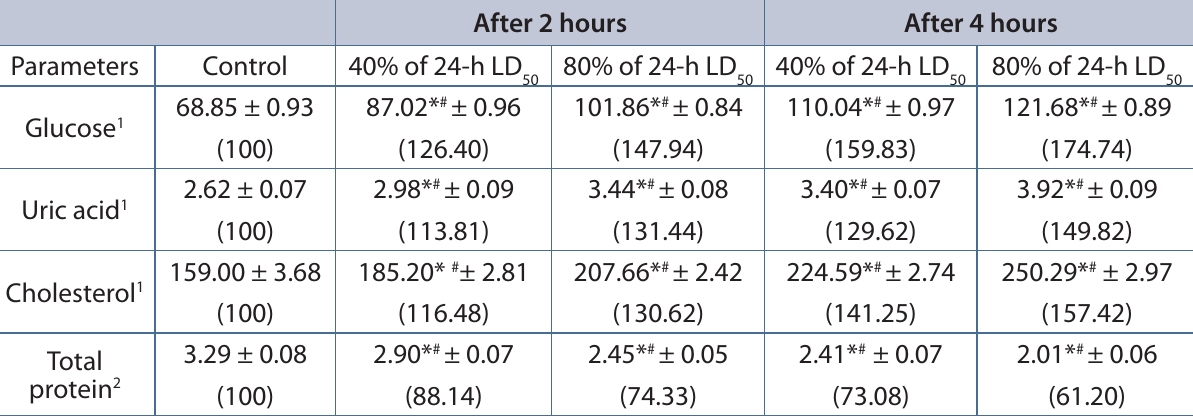
Table 1. Effect of 40% and 80% of 24-hour LD cholesterol and total protein levels in the blood serum of albino mice